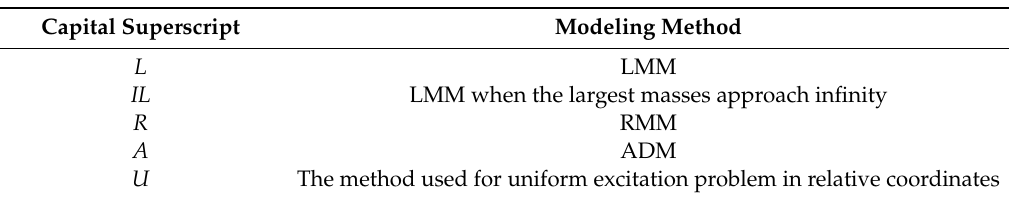
Table 1. List of the capital